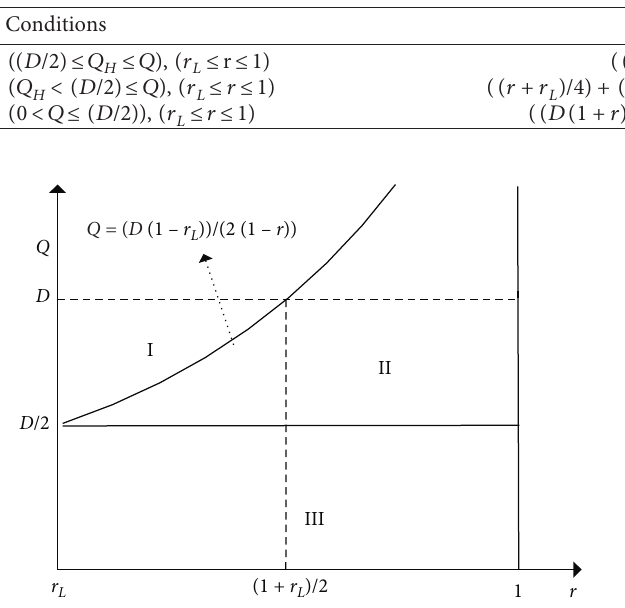
Figure 4: Retailer’s optimal pricing strategy under the influence of Q and R